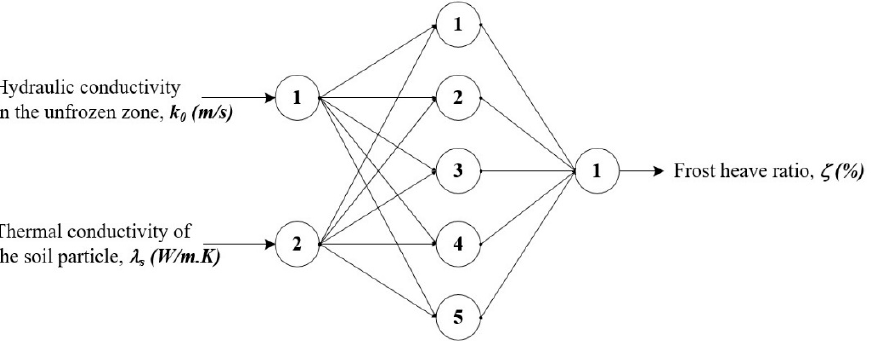
Figure 7. Artificial neural network model for estimating the frost heave ratio.